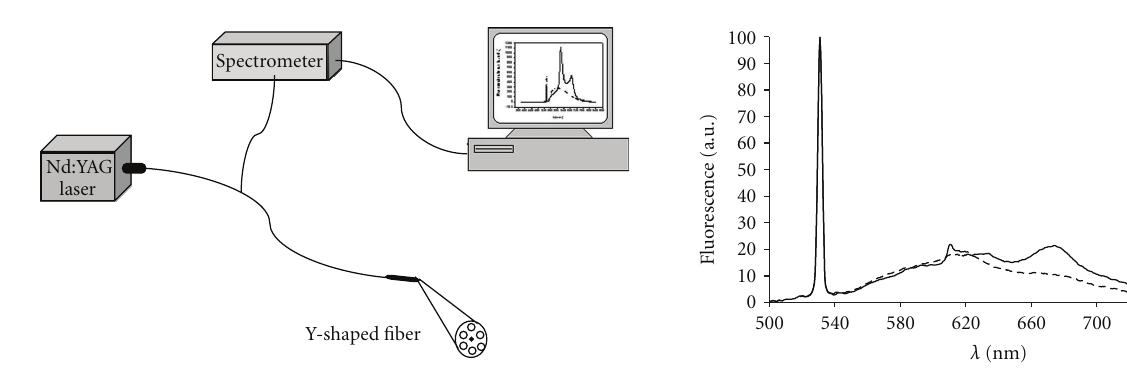
Figure 1: Schematic representation for the experimental setup.